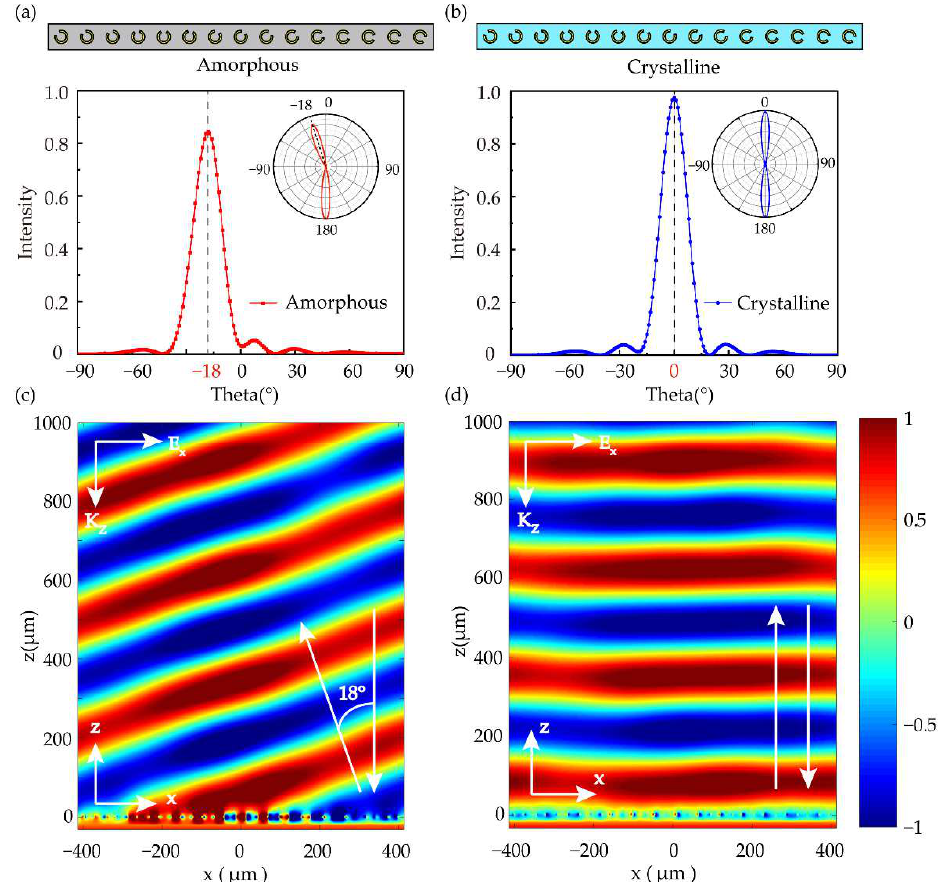
Figure 6. Simulated cross-polarization and co-polarization reflection intensity as a function of orientation angle φ in amorphous states ( a ) and crystalline states ( b ), where the insets are the simulated polar. The distributions of electric field Ex in the periodic unit cell under the illumination of LCP at the resonant wavelength of 1.1 THz in amorphous ( c ) and crystalline ( d ) states (the blue and red band represent the slight variation of phase).